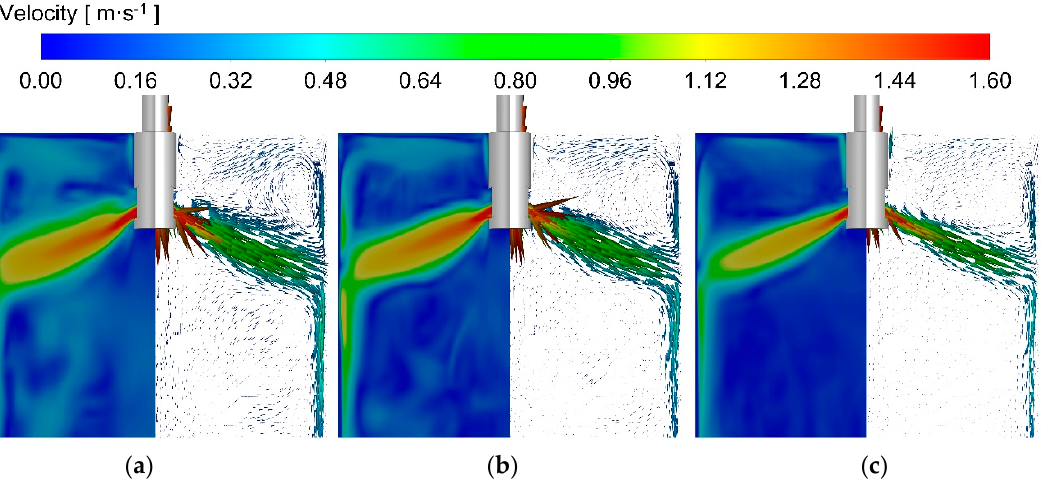
Figure 8. Contour and vector diagram of velocities in mold at the argon gas flow rate of 6 L·min − 1 under the different EMBr modes of: ( a ) Mode 1, ( b ) Mode 2, ( c ) Mode 3.